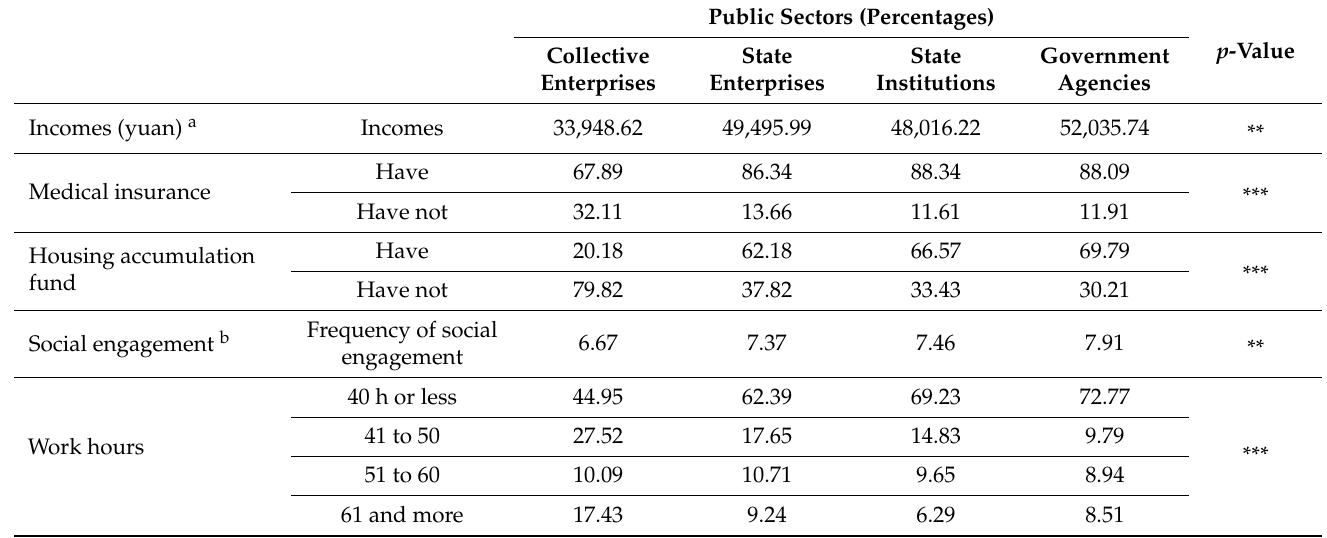
Table 5. The difference in welfare among public sectors (100%).